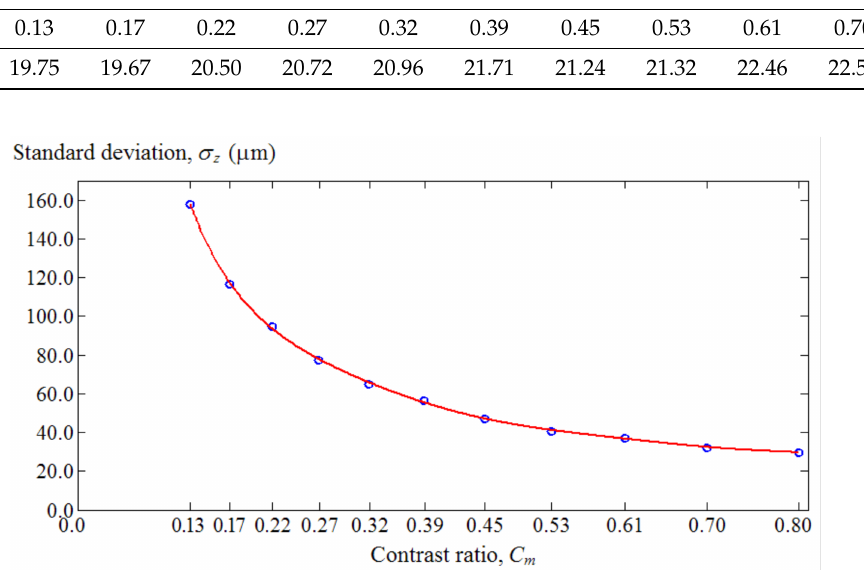
Figure 15. Relationship between the standard deviation of the depth profile and the input fringe